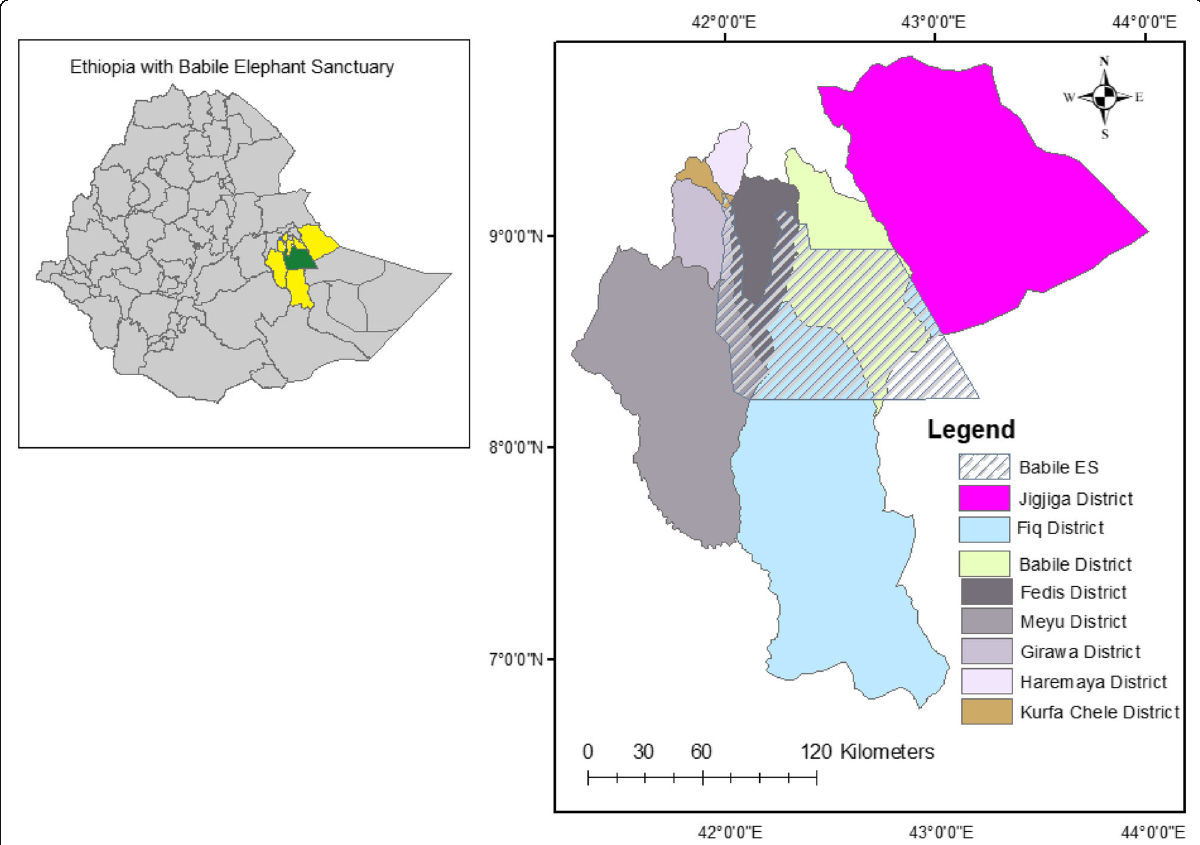
Fig. 1 Location of the study area, Babile Elephant